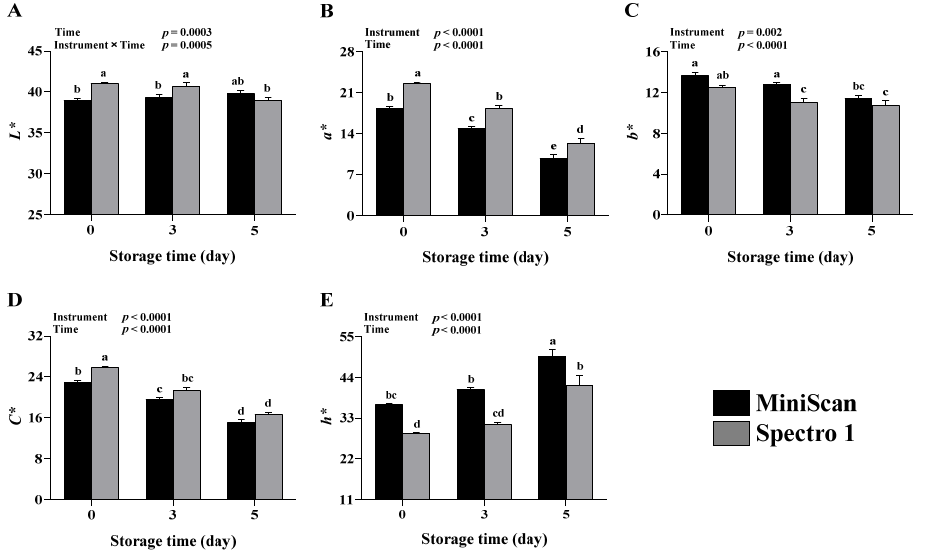
Figure 2. Lightness ( L *; ( A )), redness ( a *; ( B )), yellowness ( b *; ( C )), chroma ( C *; ( D )), and hue ( h *; ( E )) values obtained from beef steaks at 0, 3, and 5 days of storage using Spectro 1 and MiniScan ( n = 12). Data are least-squares mean ± SE. a–e Means lacking a common letter differ significantly ( p ≤